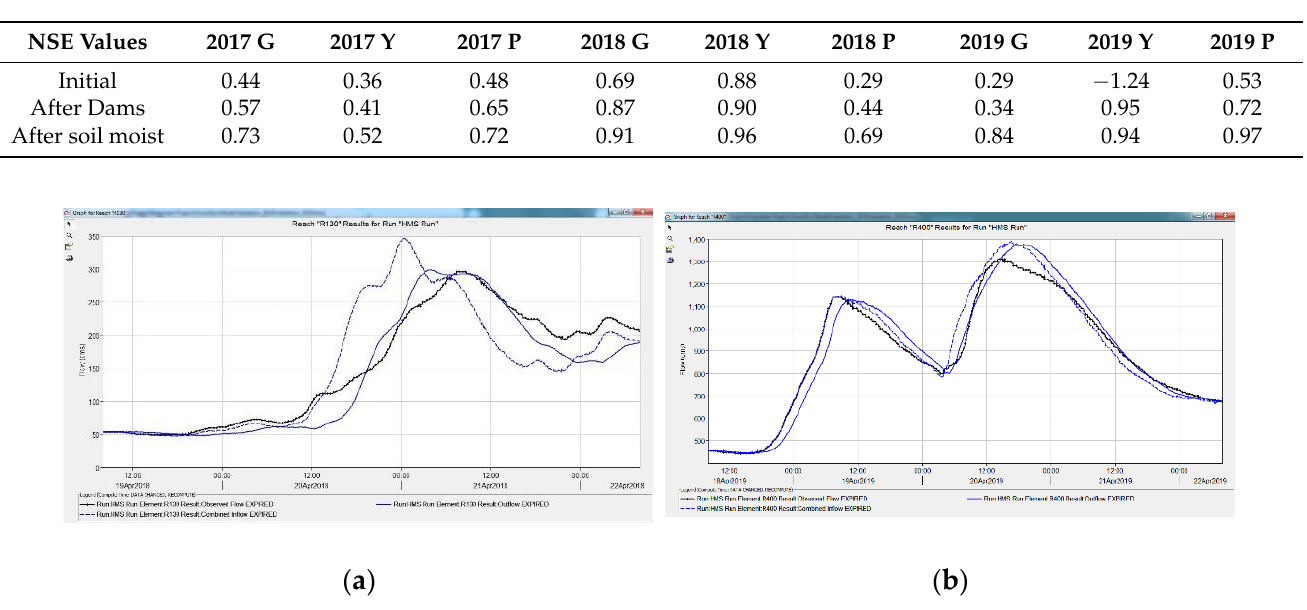
(as in Figure 4) regenerated via the modified HEC-HMS. The simulated graphs in blue for both events have high similarities with their actual graphs in black. In Yangshuo, with a double peak hydrograph (in which the first bump is the dam release prior to an estimated heavy rainfall), both peaks were forecasted as we also included the dams in the model. The NSE values from − 1.24 for Yangshuo and 0.69 for Guilin (Figure 4a,b) increased to 91% and 95%, respectively, which showed a high forecasting accuracy. Table 1. NSE values for the three simulated flood events (2017, 2018, and 2019) in Guilin (G) Yangshuo (Y) and Pingle (P) before and after LSTM modifications with ARCK and dams vs. initial simulations.